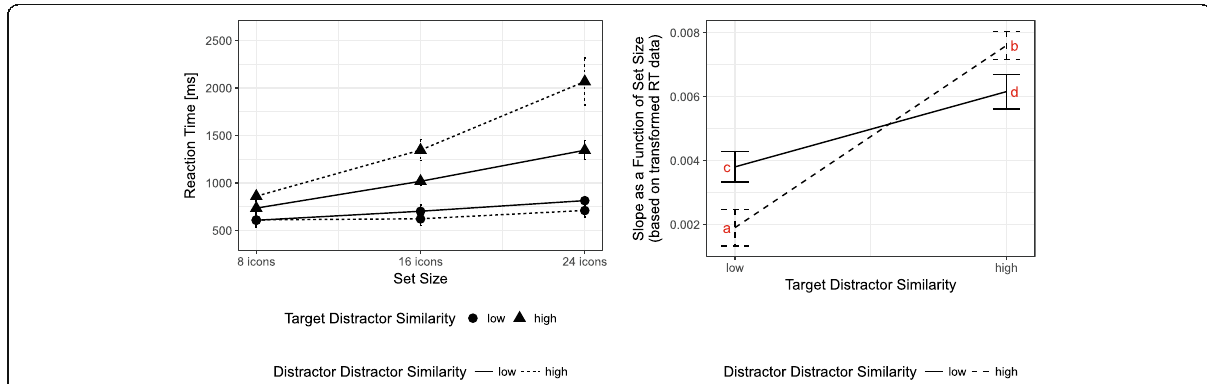
Fig. 3 Interactions of TDS and DDS on reaction time and on slope values as a function of set size. Small slope values indicate a search that is mostly independent of set size, i.e. is very efficient. Large slope values suggest inefficient search processes. In order to compare the results to the predictions of Duncan and Humphreys (1989), depicted in Fig. 1, the letters a to d were added to the graph on the right . All analyses were conducted on slope values based on transformed reaction time ( right graph ), although original values are also shown ( left graph ). The slope values based on the original data for low TDS condition are 13 ms/icon (low DDS) and 6 ms/icon (high DDS) and for the high TDS condition are 38 ms/icon (low DDS) and 75